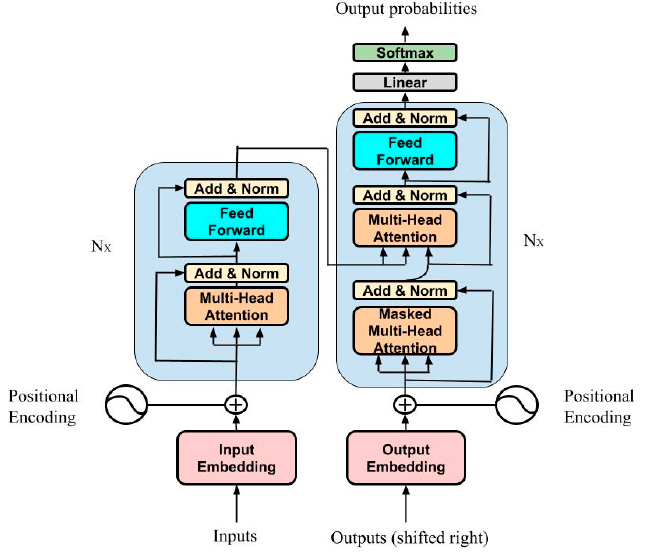
Figure 4. Transformer architecture. In supplementary material (Section S2), an accurate description of the architecture is reported. (https://keras.io/examples/timeseries/timeseries_transformer_classification/, accessed on 7 February 2023). 2.5. Model Selection and Comparison 2.5.1. Implementation and Selection of Models For each selected model, parameter scanning was performed, and the best model was selected. Below, procedures are indicated according to models. SARIMAX: Augmented Dickey–Fuller (ADF) tests, applied to a weight time series, yielded p- values larger than α = 0.05 for 90% of the overall participants. Therefore, we transformed the weight time series into a stationary one that performed first-order differentiation. The ADF test, repeated on preprocessed series, confirmed stationarities for all of the transformed time series. Following this adjustment, the terms d and D were each set to 1. We started with fitting a SARIMAX model for all the datasets available, considering the ranges in Table 1. Table 1. Parameter range for the selection of the best SARIMAX model. p